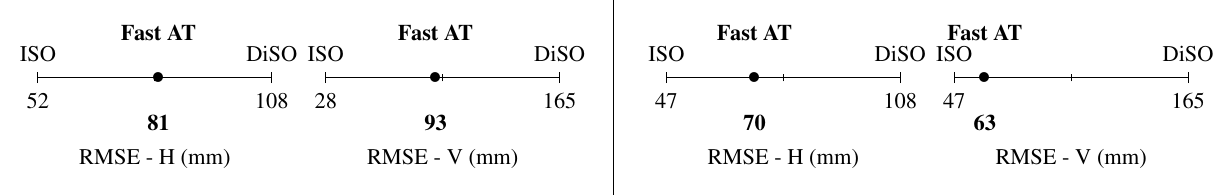
Table 5: RMSE of ChPs of selected P-C and S-C configurations.